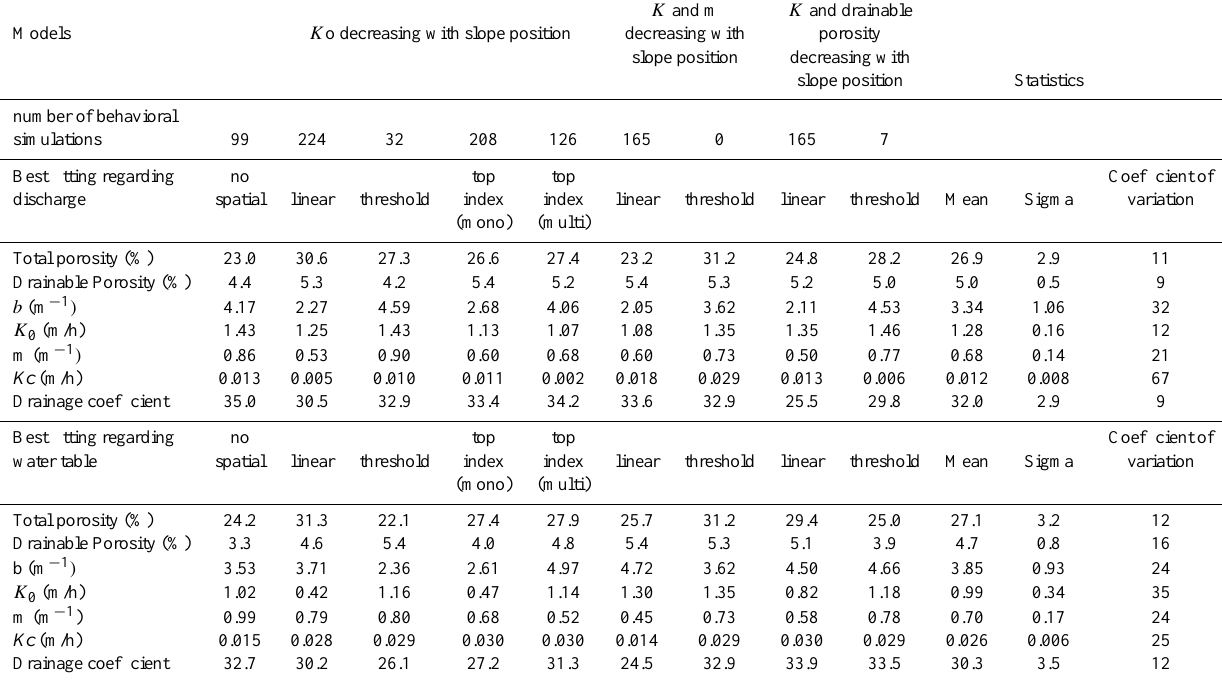
consider K 0 ,m and drainable porosity increase from downslope to